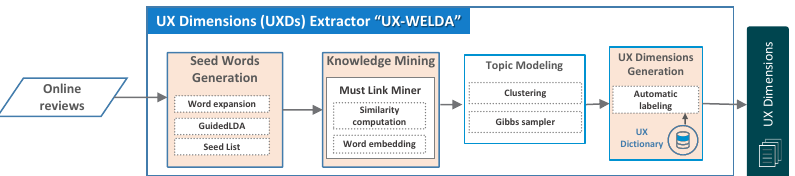
Figure 6. Abstract workflow for UX Dimensions